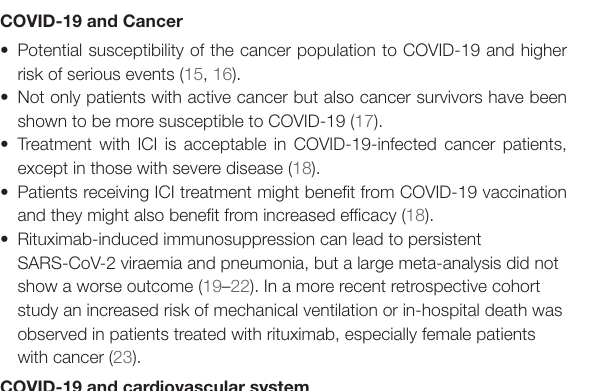
TABLE 1 | COVID-19, cancer and cardiovascular